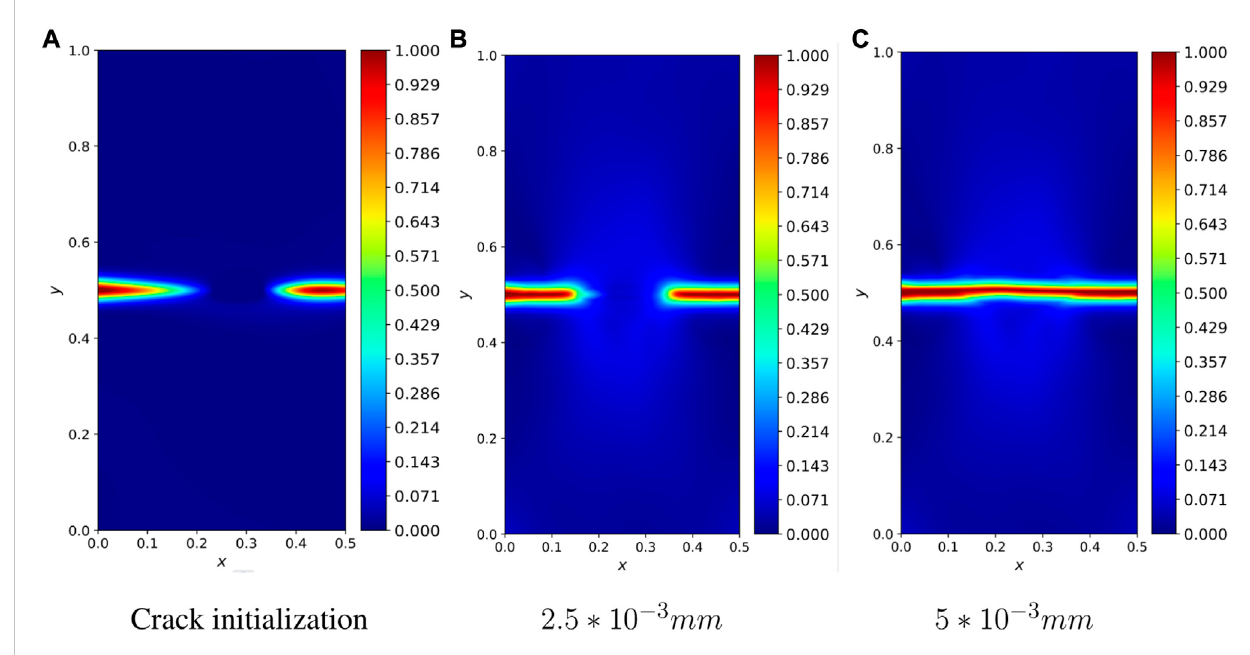
FIGURE 11 Phase fi eld images of Symmetric double notched plates at l 0 = l p , (A) Crack initialization, (B) 2.5 * 10 − 3 mm, (C) 5 * 10 − 3